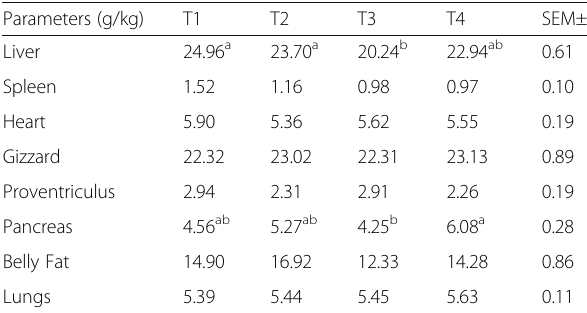
Table 5 Relative organs weight of broiler fed fungi